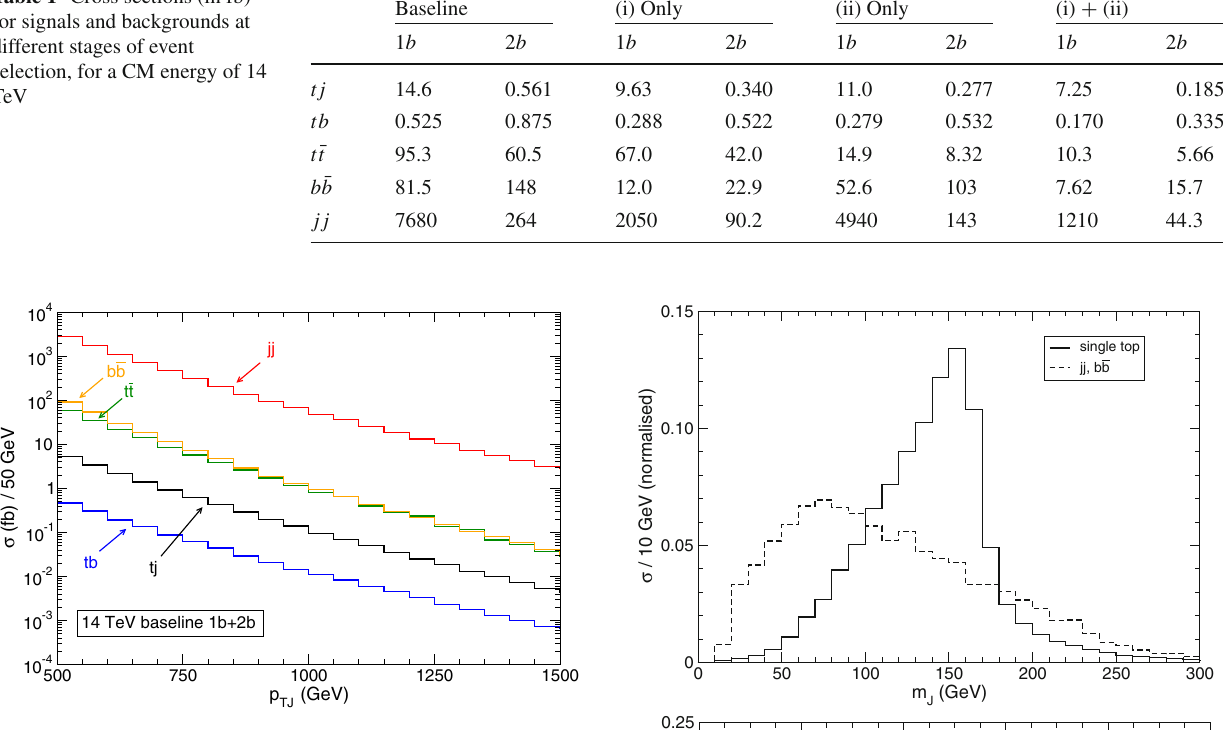
Table 1 Cross sections (in fb) for signals and backgrounds at different stages of event selection, for a CM energy of 14